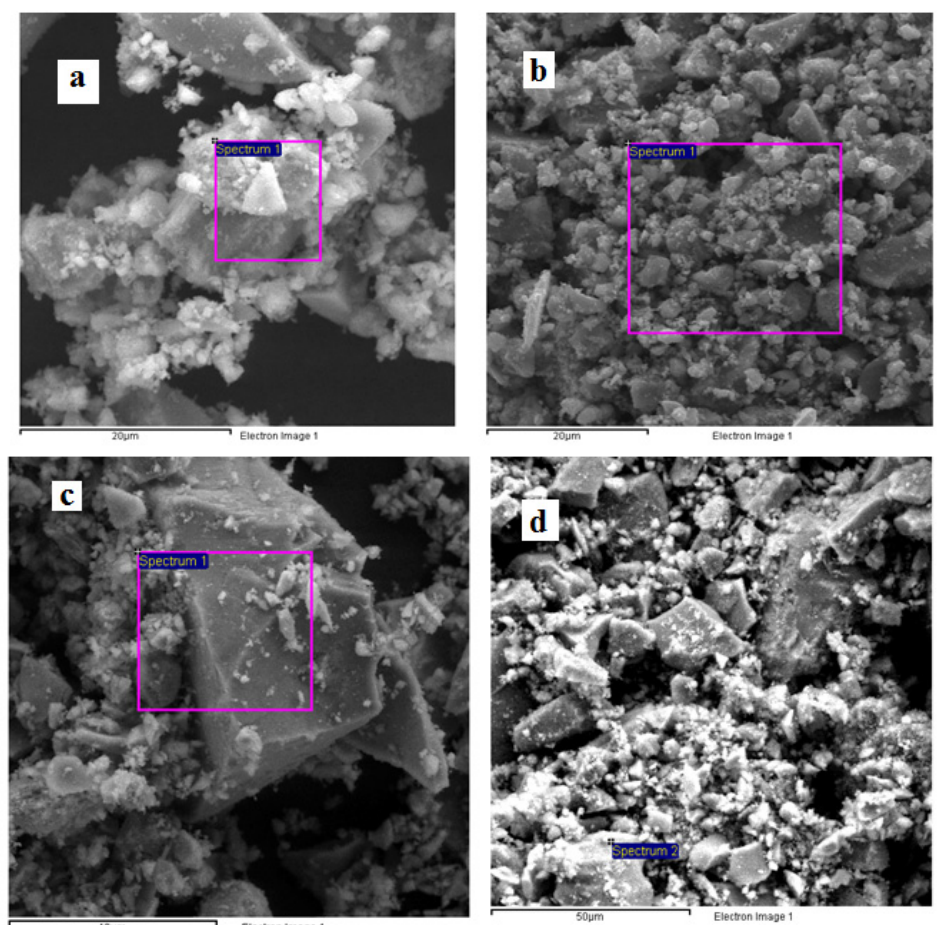
Fig. 8. SEM images of a) 0.2% Ni 500, b) 0.5% Ni 500 c) 0.7% Ni 500 and d) 1.0%